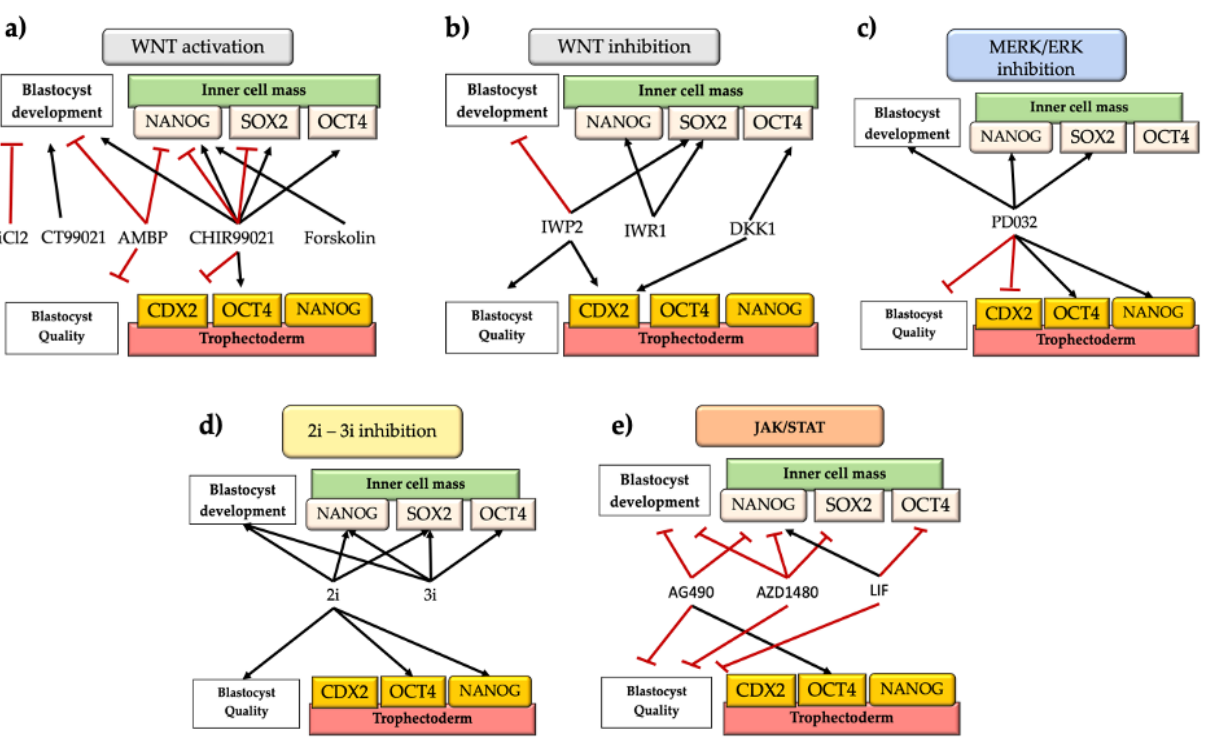
Figure 2. Effects of small molecules on levels of pluripotency factors ( NANOG , SOX2 , OCT4 , and CDX2 ), on developmental potential in vitro and embryo quality according to total cell